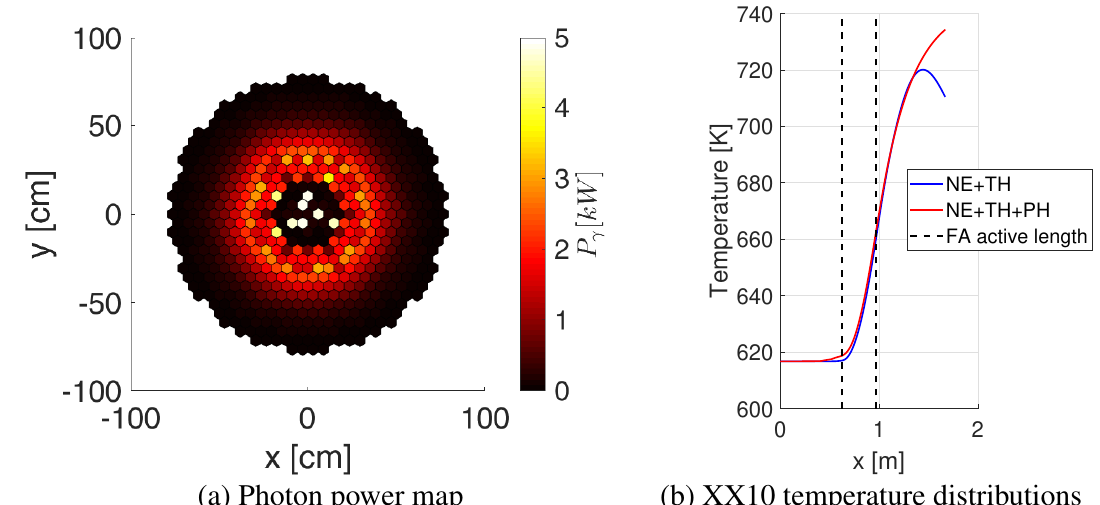
Figure 3: Steady state (NE+TH+PH) radial map of the photon power integrated per FA and comparison between the coolant temperature distributions calculated by FRENETIC in the experimental driver